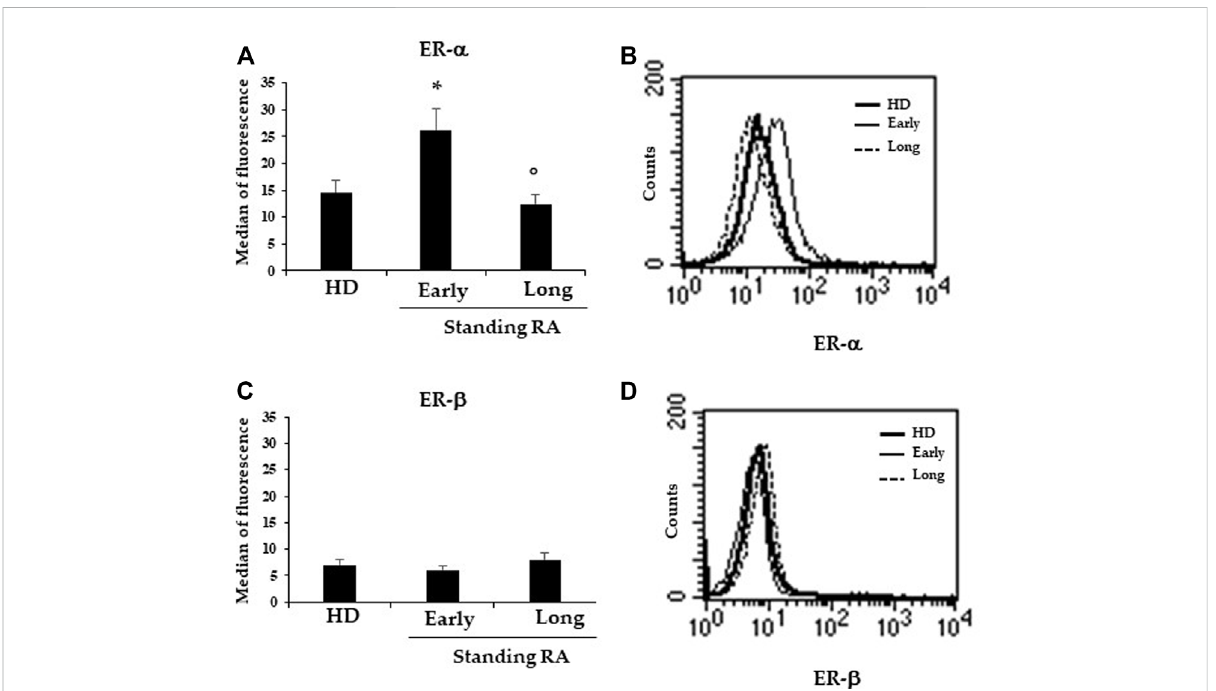
FIGURE 1 Expression of ERs in RBCs. (A) Flow cytometry analysis of ER- α expression in RBCs from 25 HD, 19 early- and 13 long-standing RA patients. (B) Dot plot showing the ER- β expression in RBCs from a representative HD, a representative early- and a representative long-standing RA patient. (C) ER- β expressioninRBCsfrom25HD,19early-and13long-standingRApatients. (D) DotplotshowingER- β expressioninRBCsfromarepresentative HD, a representative early- and a representative long-standing RA patient. * p ≤